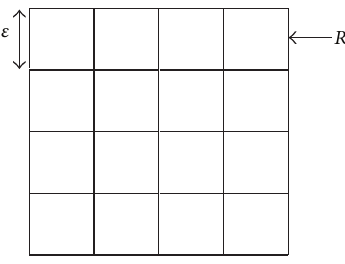
Figure 1: Partition of the support 𝑆 by squares of side length 𝜀 .